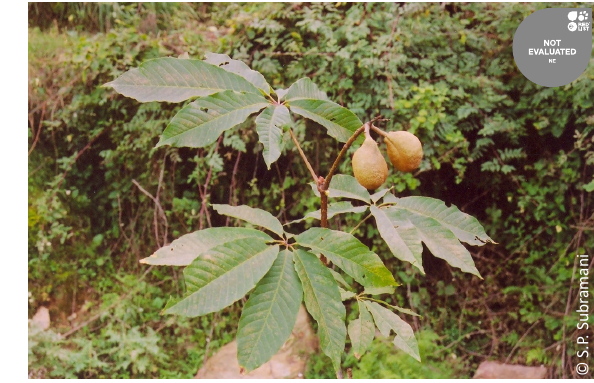
Image 33. Acer caesium Wall. ex Brandis